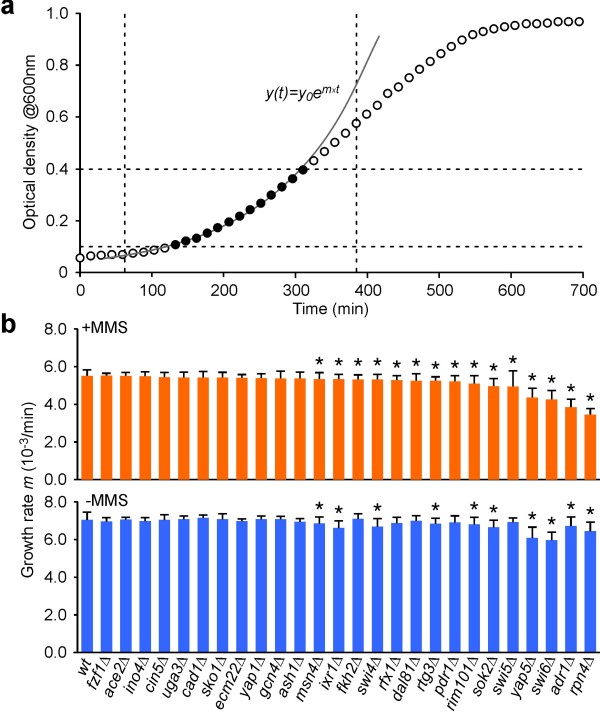
Growth rate measurements. (a) Representative optical density time course (open circles) illustrating the data used to estimate the logarithmic growth rate (filled circles). (b) Growth rates of the single TF deletion mutants in the presence and absence of MMS. Error bars indicate standard deviation. Asterisks indicate strains with altered growth rates compared to the wildtype (T-Test; P < 0.05).